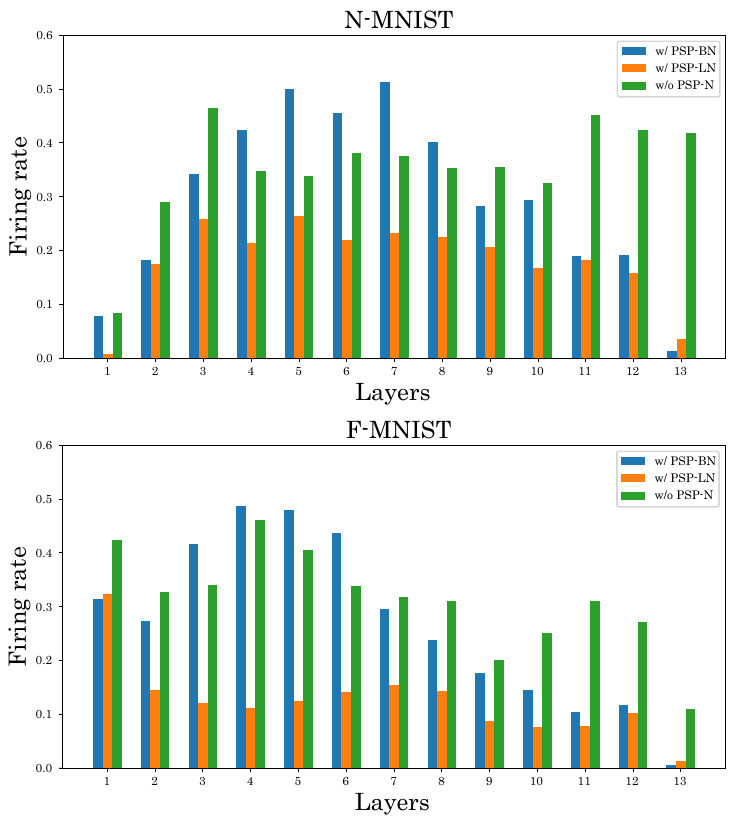
Figure 8. Comparison of firing rates. The top is N-MNIST and the bottom is F-MNIST.